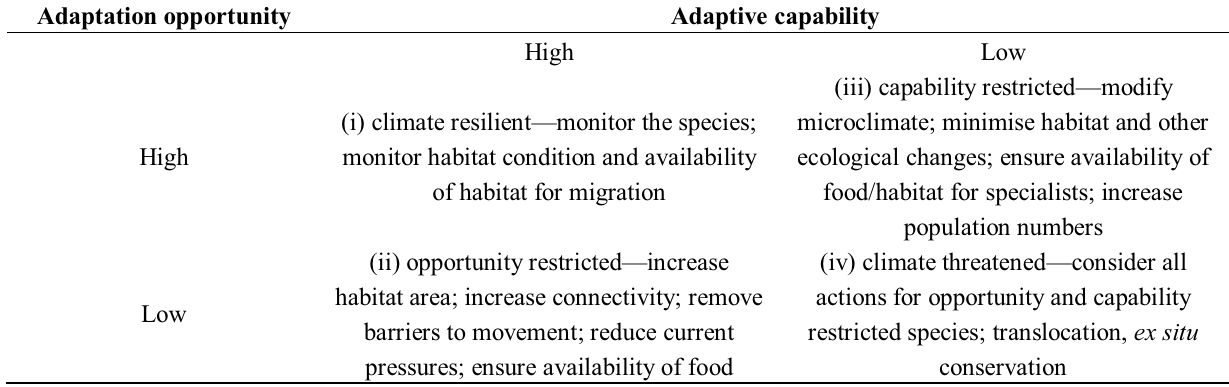
Table 8. Classification of species vulnerability and potential conservation